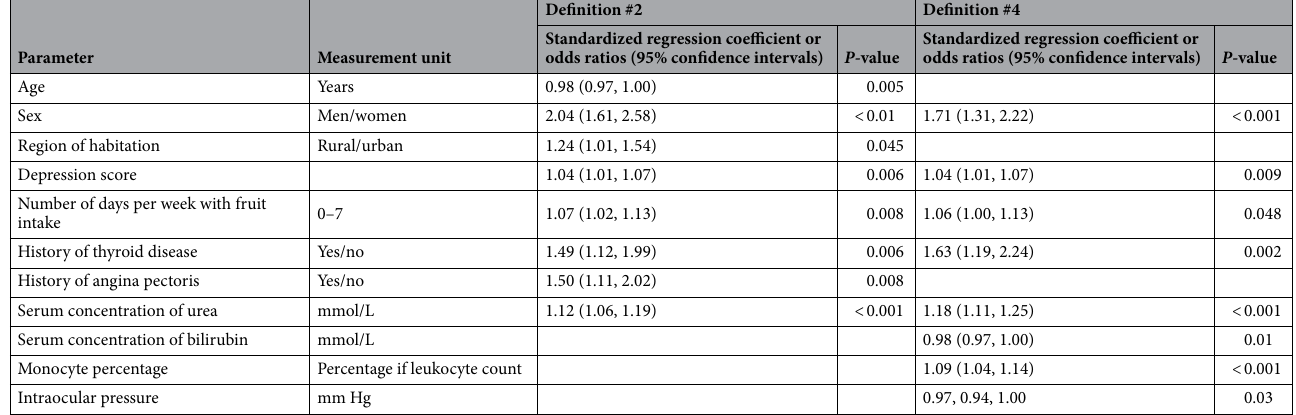
Table 5. Associations (multivariable analysis) between the prevalence of dry eye disorder definition #2: dry eye symptoms score was ≥ 2 and Schirmer´s test of < 5 mm or the prevalence of dry eye disorder